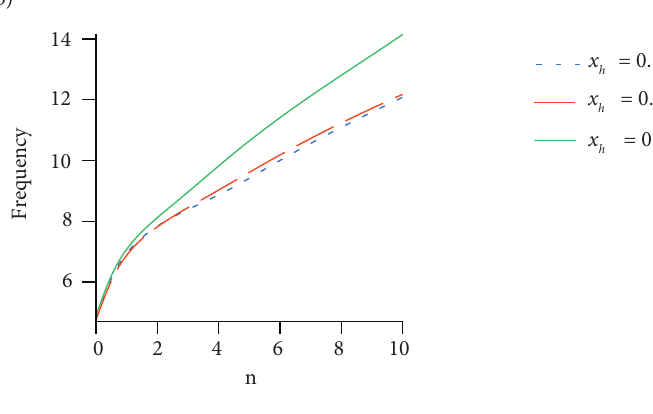
Figure 18. Thermoacoustic characteristics of a ducted resonator as resonator position varies (3L mode, τ = 0.6, x = 0.10, V = 0.2, ω = 2) showing (a) growth rate and (b) f h